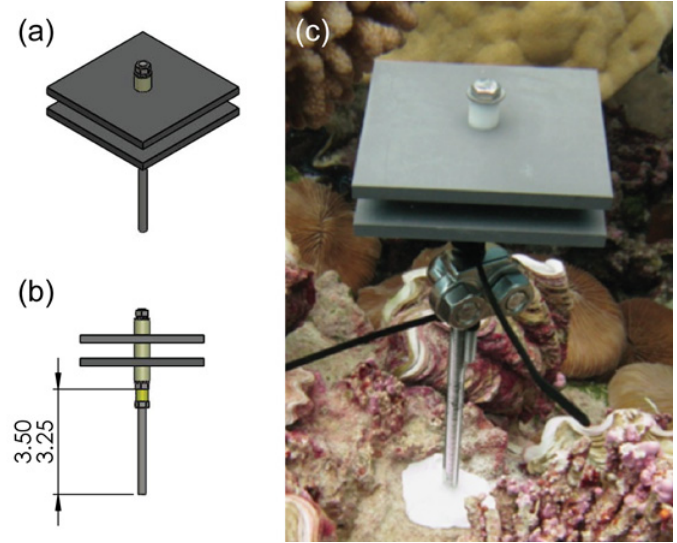
Fig 2. CAU assembly unit: a) oblique view, b) side view, and c) in-situ image of deployed CAU unit. (Photo and figure credit: Coral Reef Ecosystem Division,